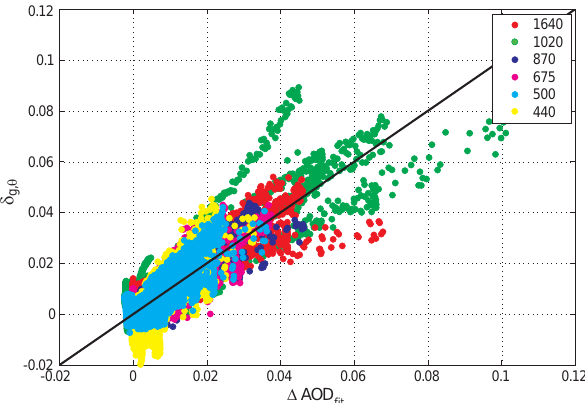
Figure 5. Scatterplot with parameterized ( δ g,θ ) and measured ( (cid:49) AOD fit ) AOD differences. Solid line is the diagonal ( y = x ).